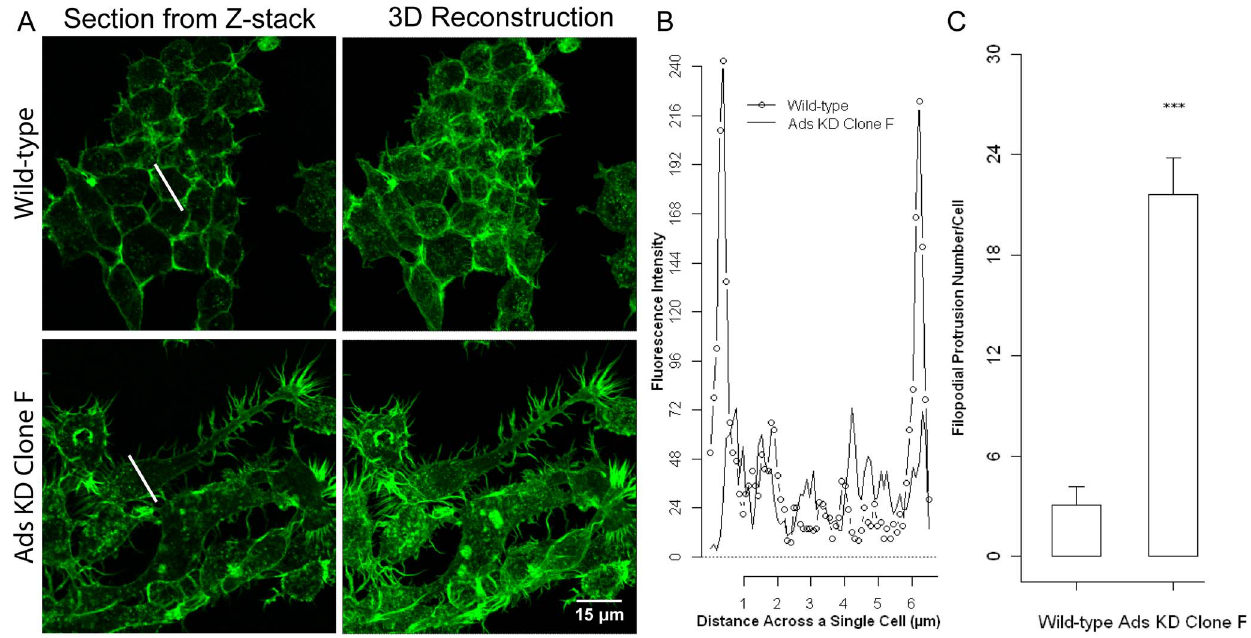
Figure 9. Adseverin knockdown alters F-actin architecture and cellular morphology in osteoclast precursors. A ) WT RAW and Ads KD osteoclasts precursors were stimulated with sRANKL for two days, fixed and stained with green- fluorescent phalloidin to localize F-actin. B ) F-actin intensity was plotted against the diameter of a cell (white line, Fig 9A). Well-defined cortical actin rings were noted in the periphery of WT cells as noted by high intensity fluorescence peaks at the cell boundaries, 0.5 m m and 6 m m. Fluoresce intensity across Ads KD cells was ill defined and lacked the characteristic peaks seen in the WT cells. Ads KD had a motile phenotype characterized by dense actin rich structure and significantly increased number of filopodial extensions at the cell periphery when compared to WT. C ) The number of filopodial extensions of each cell type was determined. WT cells (leftmost column) had an average of 3 ( + / 2 1) and Ads KD Clone F cells (rightmost column) had an average of 22 ( + / 2 2) such membrane extensions.